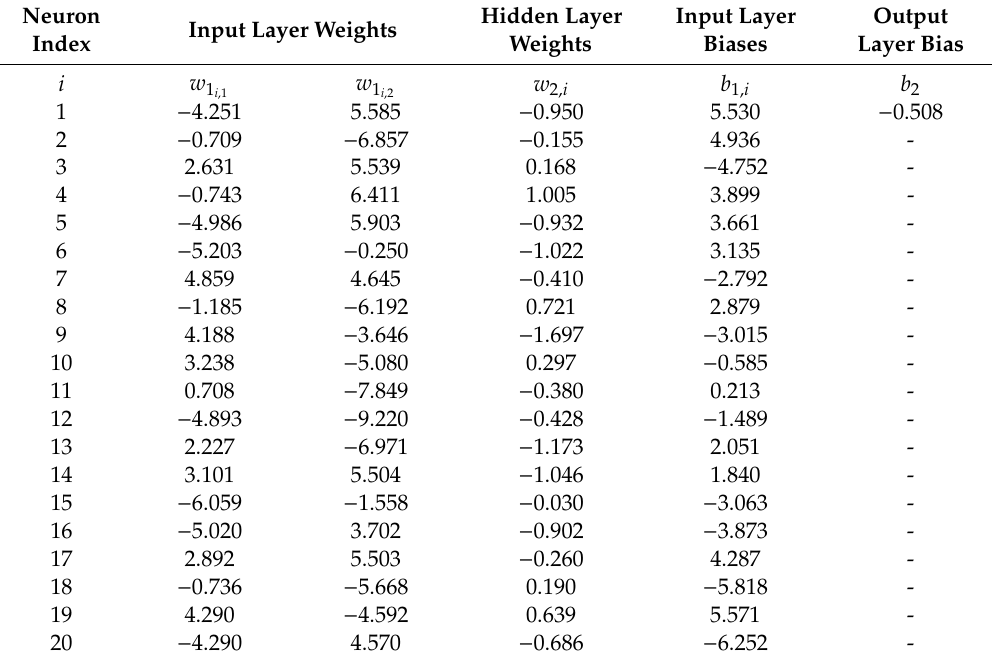
Table 4. The optimized coe ffi cients for estimating the normalized Y Pn in Equation (10).